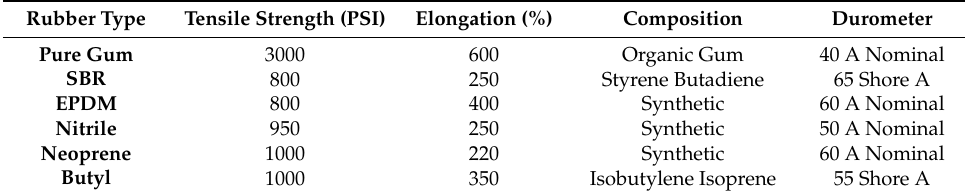
Table 2. Rubber properties as provided by the manufacturer.